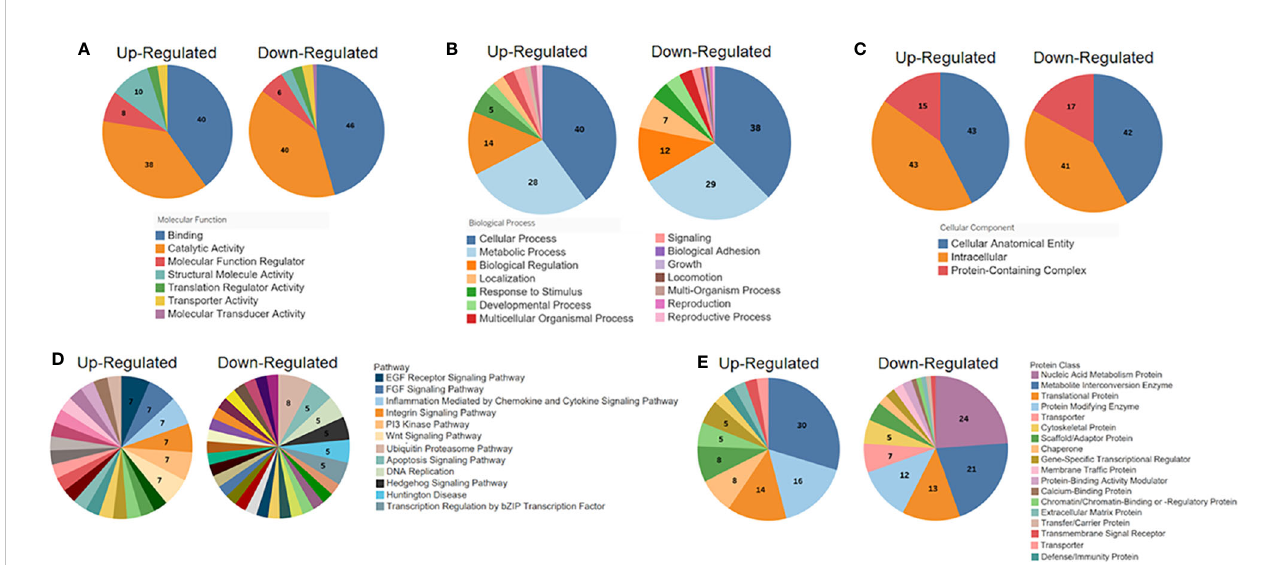
FIGURE 4 PANTHER classi fi cation (http://pantherdb.org) analysis of the signi fi cantly differentially ubiquitinated proteins by (A) molecular function, (B) biological process, (C) cellular localization, (D) pathway, and (E) protein class. For each set of classi fi cations, proteins with up-regulated ubiquitination in the presence of Nef (left graph in each set) were analyzed and presented separately from those with down-regulated ubiquitination (right graph in each